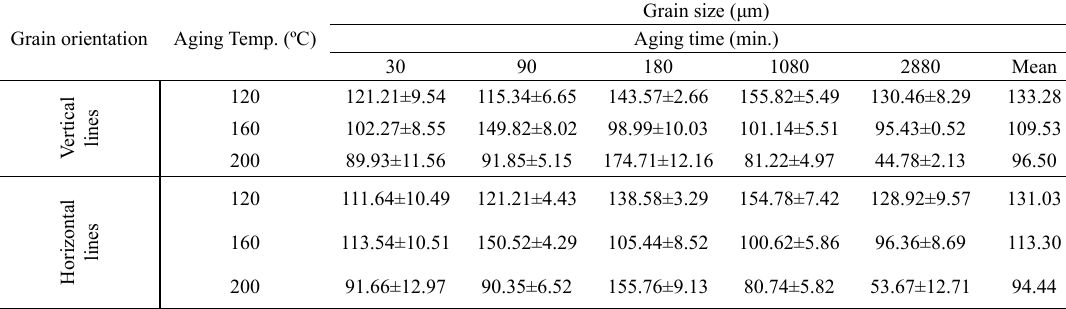
Table 3. Grain size measurements and standard deviations Grain orientation Aging Temp. (ºC)